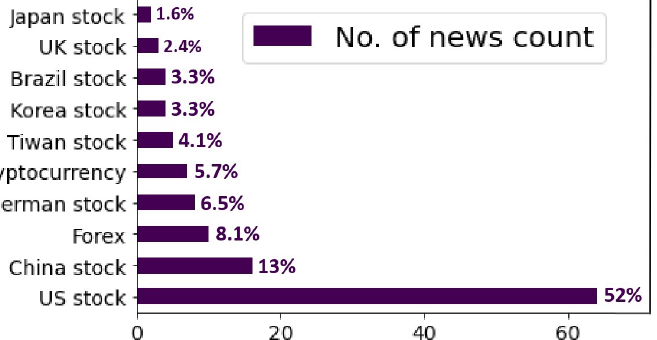
Figure 3. Distribution of reviewed works with respect to the analyzed market. Stock markets are mentioned with country names.